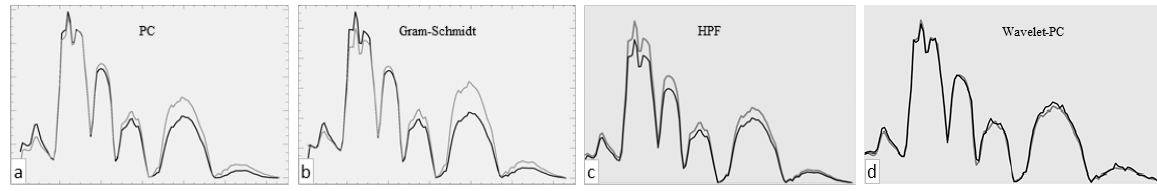
Figure 10. Quality control using spectral profile of a selected pixel of vegetation area. Grey line is from original image and black lines are from (a) PC, (b) Gram-Schmidt, (c) HPF and (d) wavelet-PC sharpened images